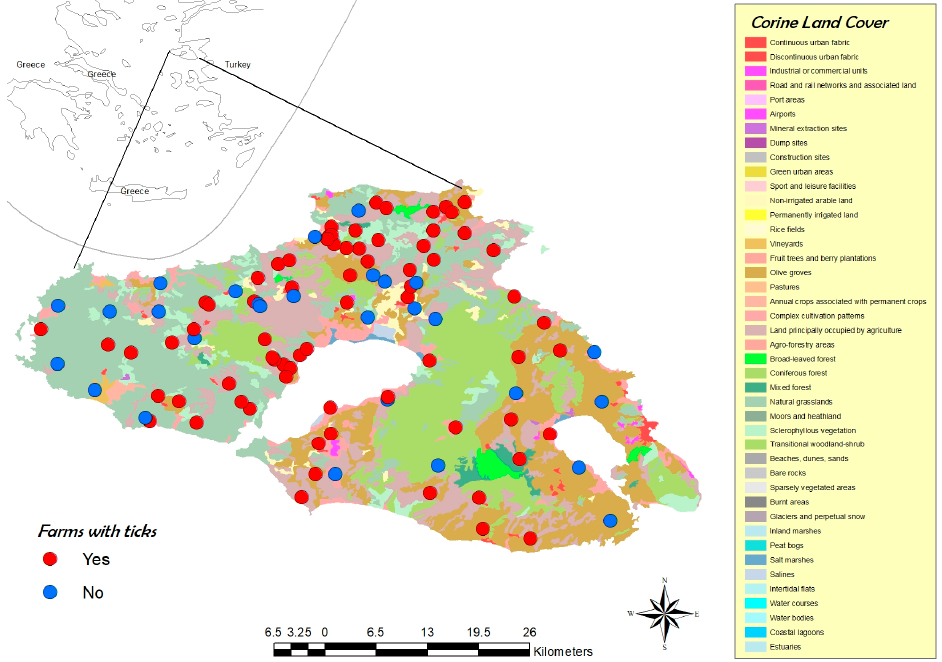
Figure 1. Distribution of sampled farms based on tick presence/absence and landscape fragmentation, according to CORINE land cover.